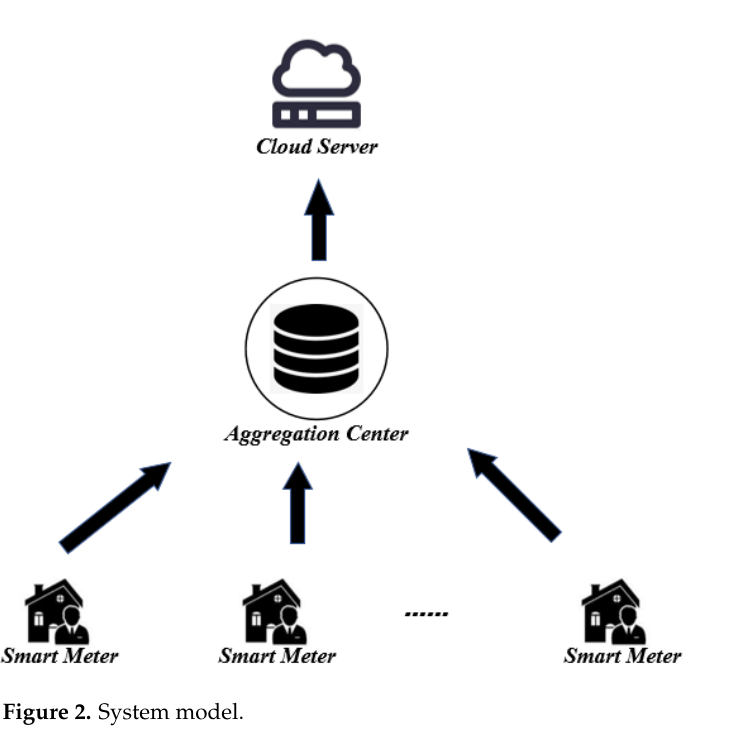
Figure 2. System